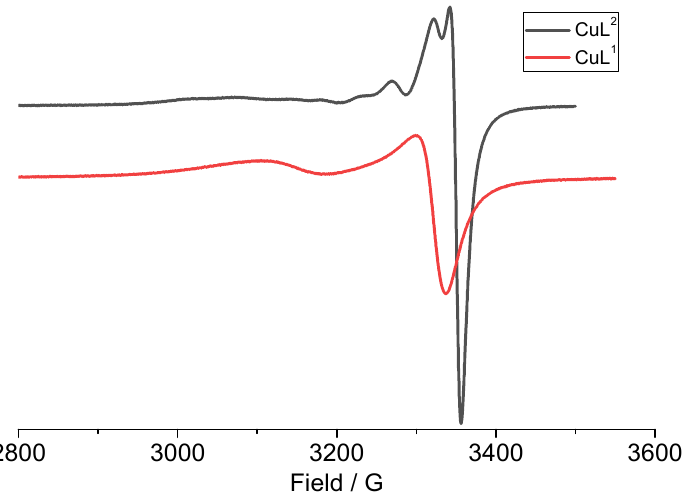
Figure 7. X-band EPR spectra of the two Cu(II) complexes [Cu(L) 2 (NO 3 ) 2 ], recorded on solid samples at frequencies of 9.642502 GHz for CuL 2 (L 2 = 2-bromo-4-methylpyridine) and 9.645555 GHz for CuL 1 (L 1 = 2-bromo-5-methylpyridine) at 298 K. Receiver gain of 40, attenuation 25 dB (0.3162 mW), 1 scan for both samples. Table 1. X-band EPR data of the two complexes [Cu(L) 2 (NO 3 ) 2 ] a . g (cid:107) g ⊥ g av ∆ g HFS b Line Width